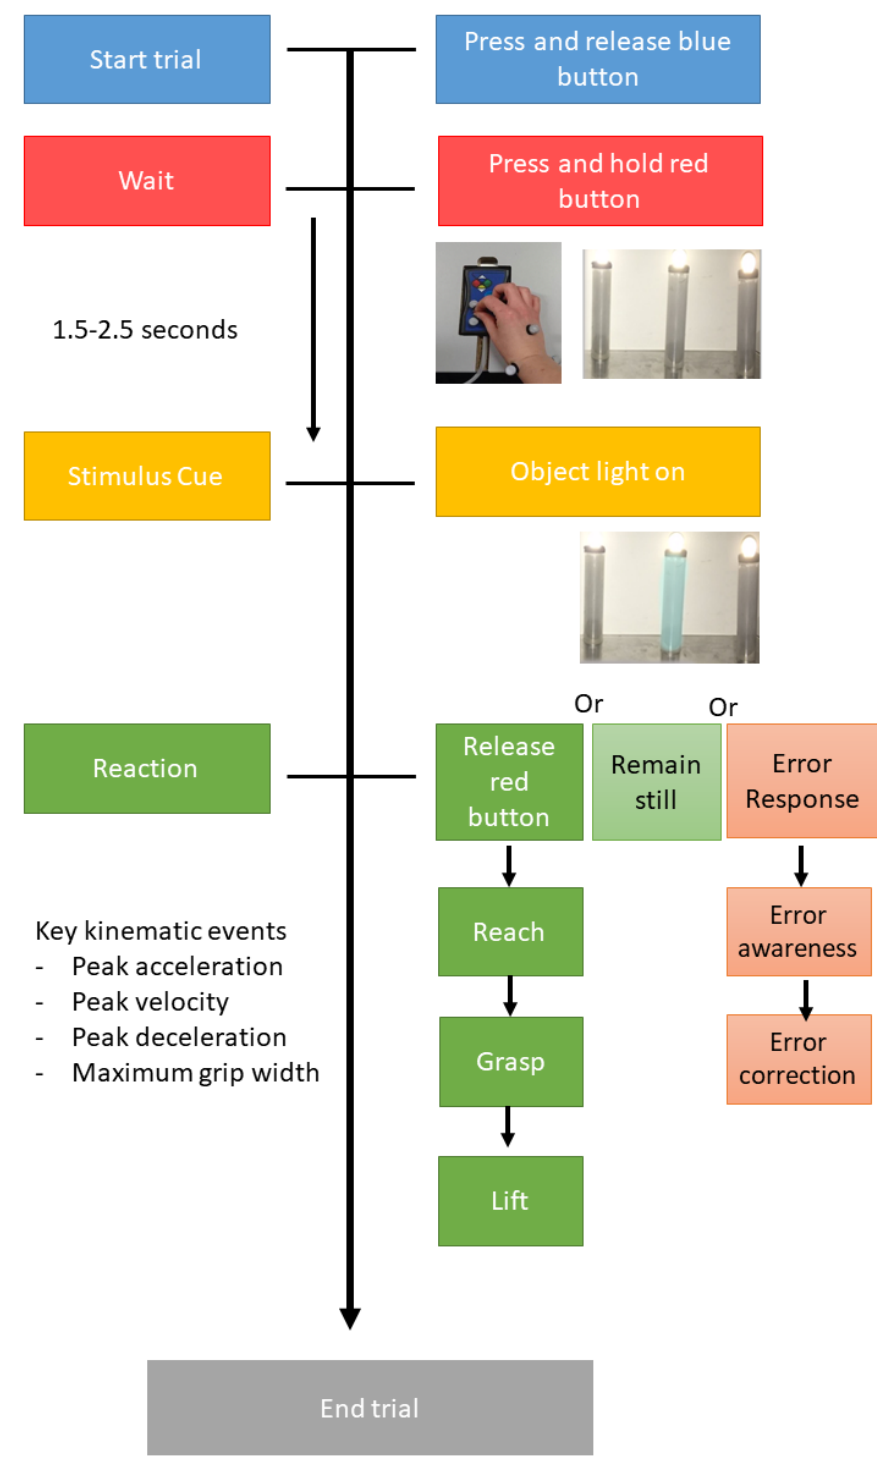
Figure 3. Timeline of task events and possible responses, from the start of the trial (blue), the attention period waiting for stimulus cue (red), the variable stimulus onset cue of light on (LO, yellow) and the reaction period (RP, green) during which a participant could reach and grasp, successfully inhibit or produce an error response. LO: light on; RT: reaction time; RP: reaction period; PA: peak acceleration; PV: peak velocity; PD: peak deceleration; MGW: maximum grip width.